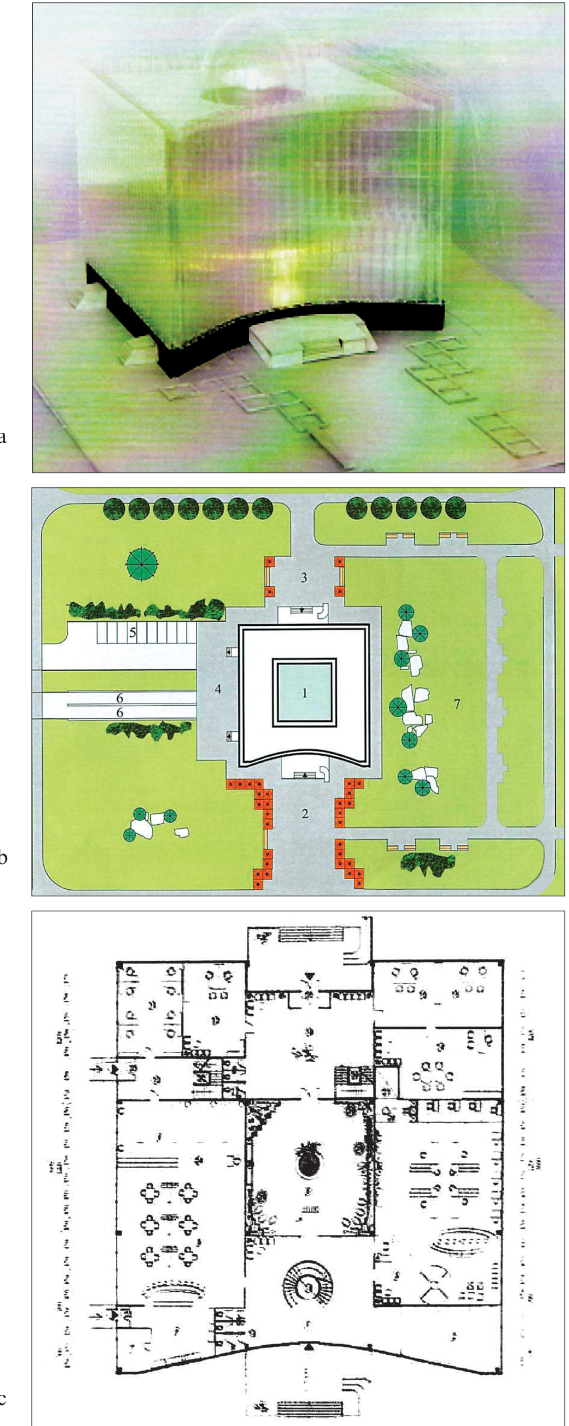
Fig 12. Conceptual Project of Public Library in Vilnius (archs K. Jakovlevas-Mateckis, L. Kostinaitė